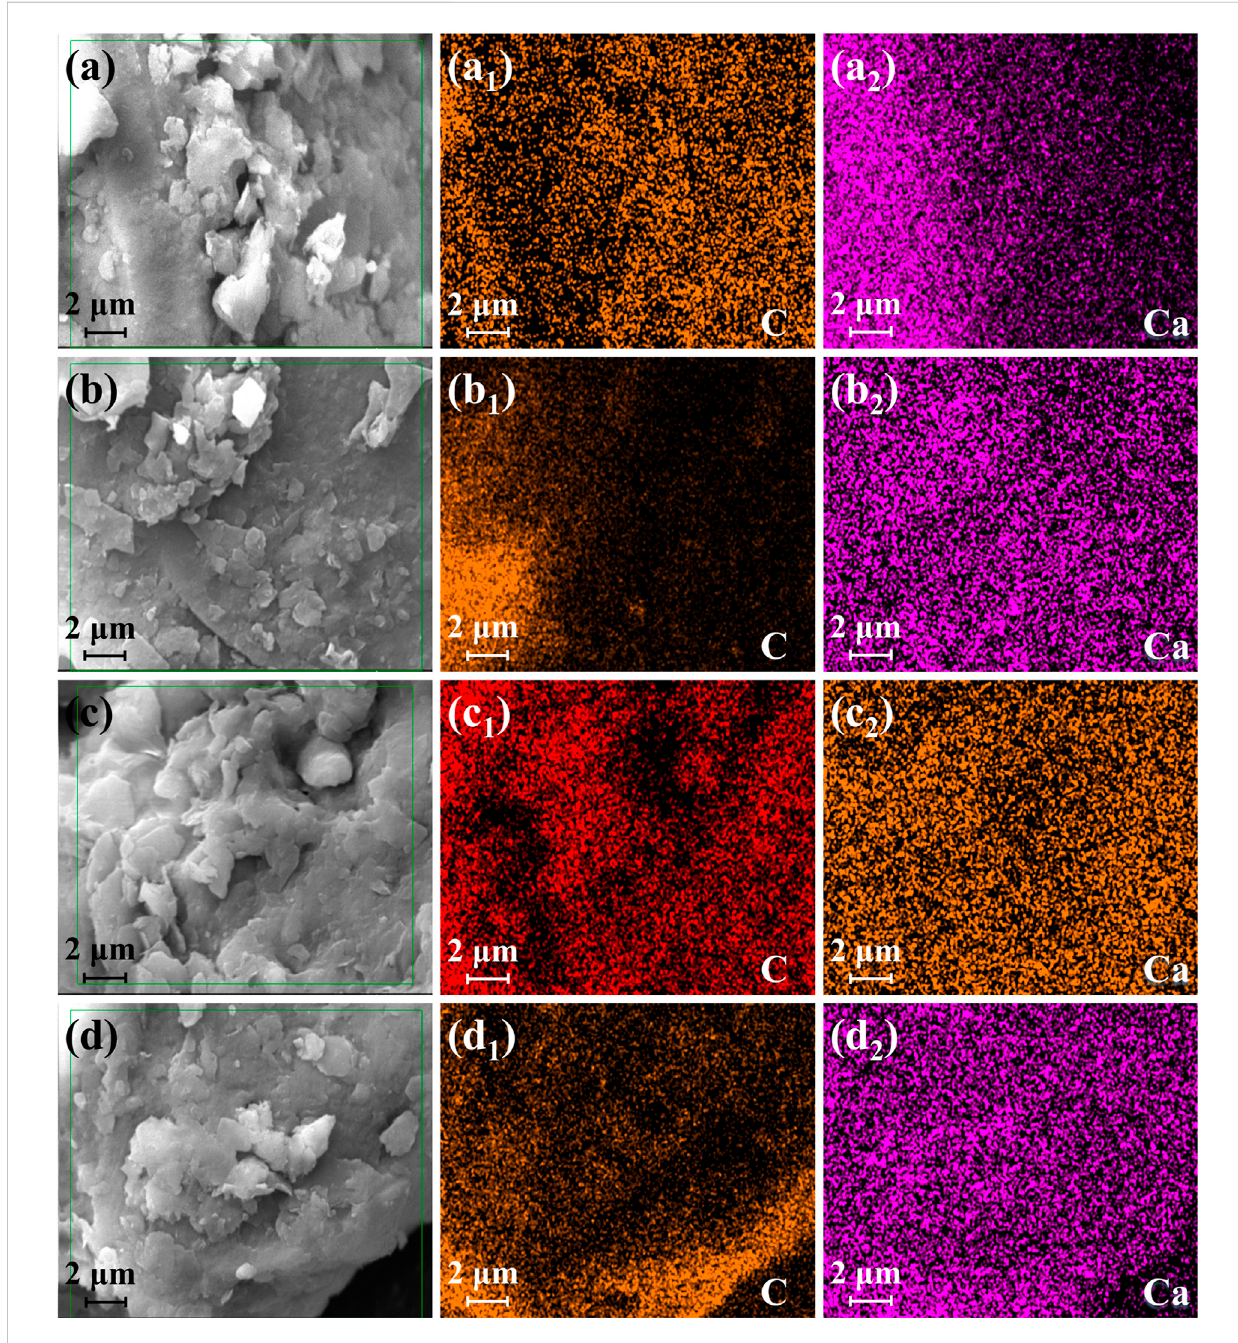
Studies have shown that variations in the ratios of Al and Fe are related to the ultrastructure of the aggregates (Figures 2, 9) (Calero et al., 2009). The distribution of elements in soils is governed by the distribution of aggregates at different grain levels, and there is a tendency for them to preferentially enrich in clay particles (Acosta et al., 2011; Huang et al.,